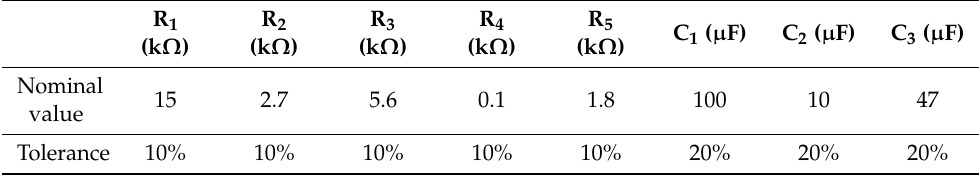
Table 1. Nominal values and tolerances of the passive components of the circuit.